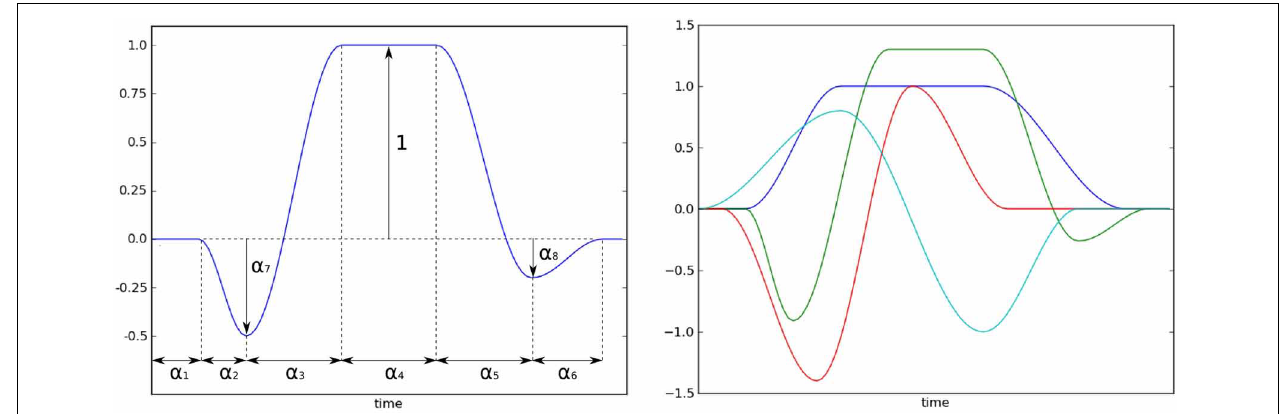
FIGURE 4 | Left: the model of the neural response shape with its parameter. Right : several shape prototypes that can be obtained with the model. The user should define this prototype, and then chooses intervals for the parameters that allows for variations of the shape around the